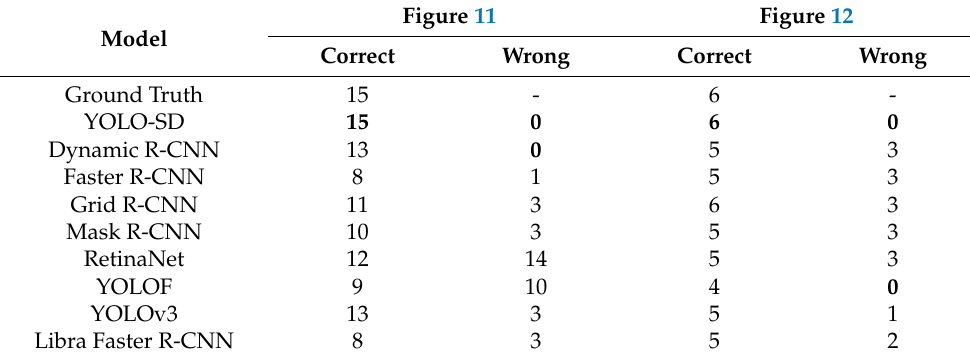
Correct indicates the number of ship targets successfully detected, Wrong means the number of false detections, and bold data is the best